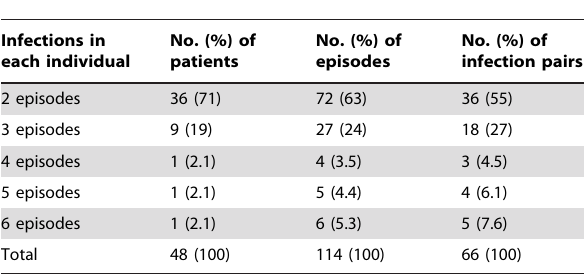
Table 1. Information of infection episodes and infection pairs among children with repeated methicillin-resistant S. aureus infections.